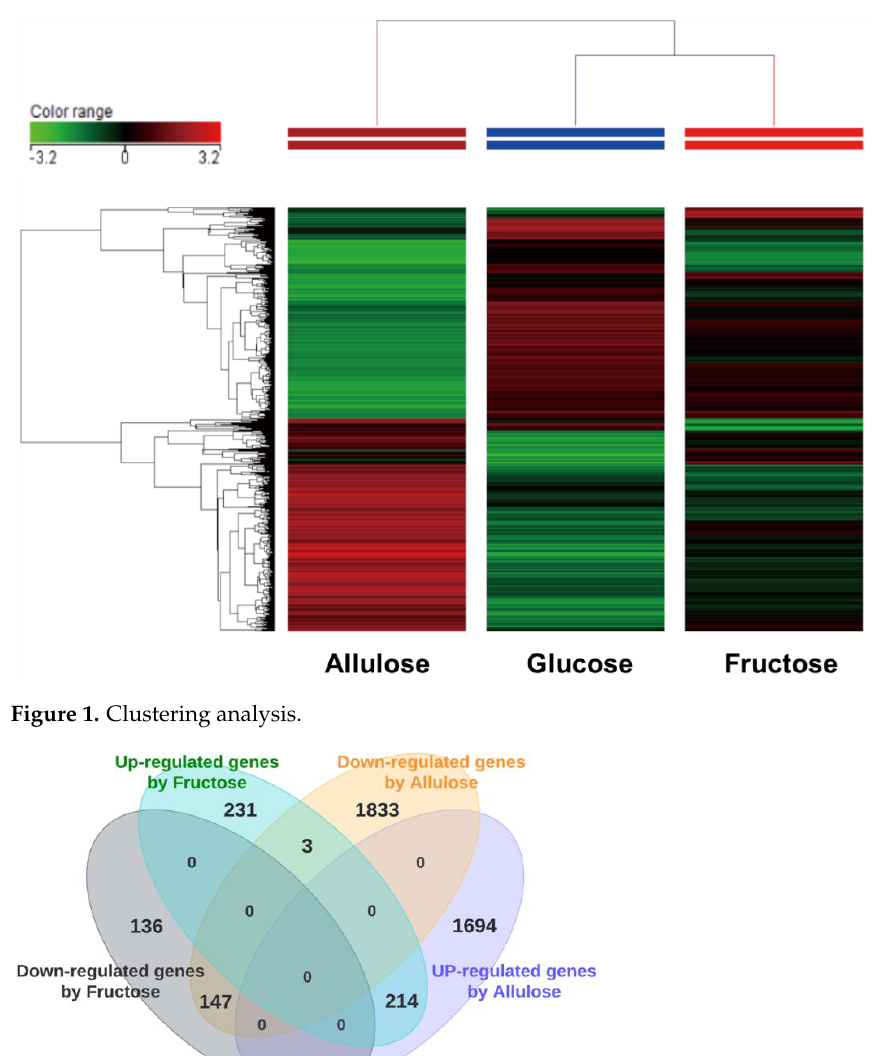
Figure 2. Venn diagram